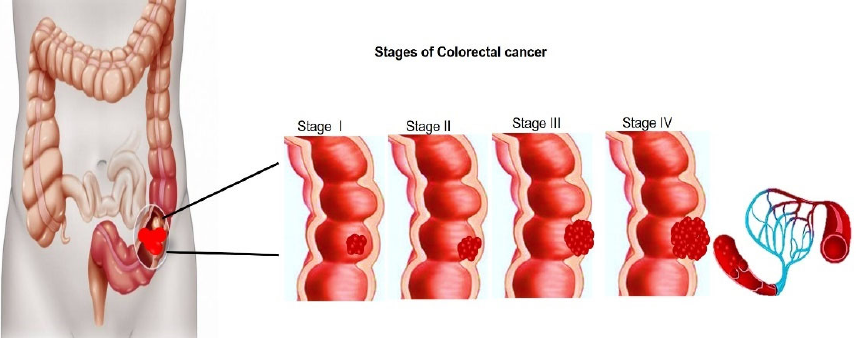
Figure 1. Different stages of colorectal cancer using the American Joint Committee (AJCC) on Cancer based on tumour, nodes, metastasis (TNM) classification.